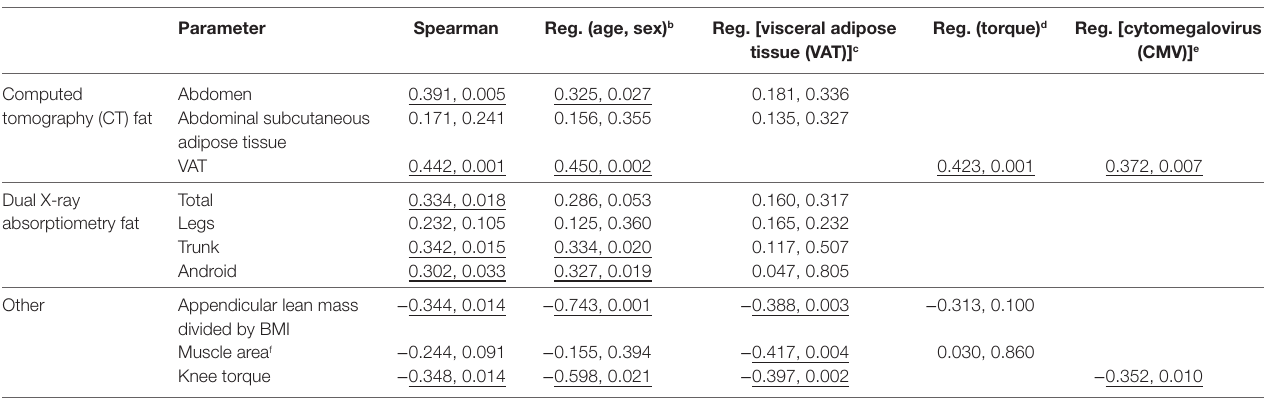
TaBle 1 | Correlations with plasma IL-15 level in Cohort D. a